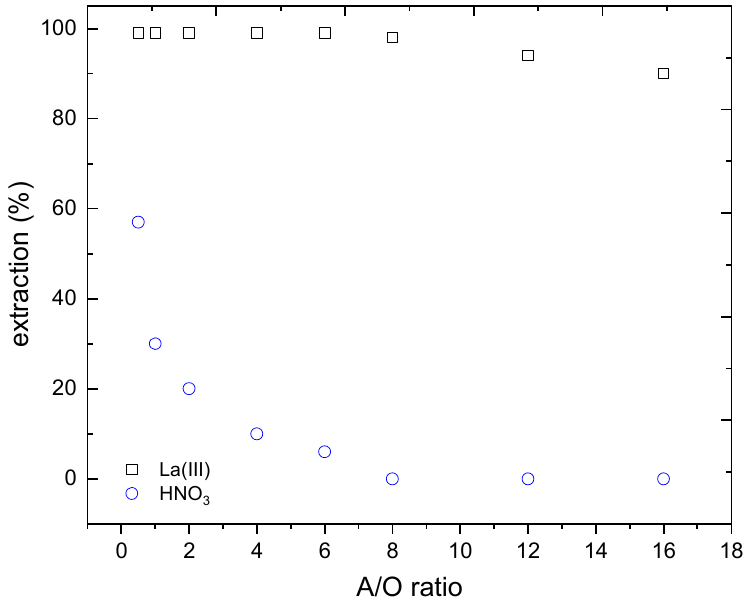
Figure 6. Separation La(III)-HNO 3 at various A/O ratios. Organic phase: 75% v/v Cyanex 923 in Solvesso 100. Temperature: 20 °C.